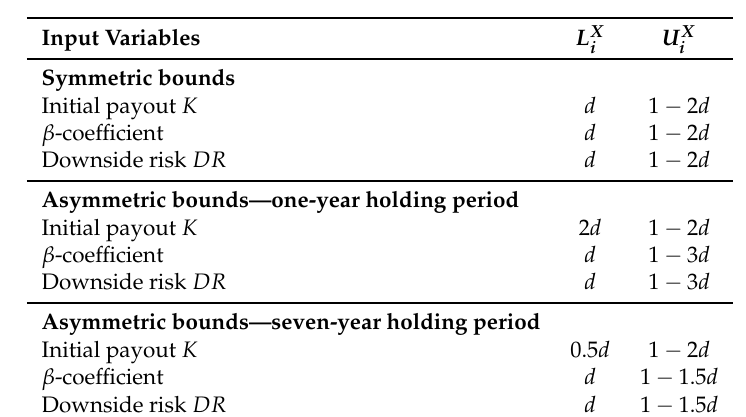
Table 1. Lower and upper bounds considered for the virtual weight restrictions applied in the performance analysis of mutual funds; d ∈ [ 0,0.25 ]